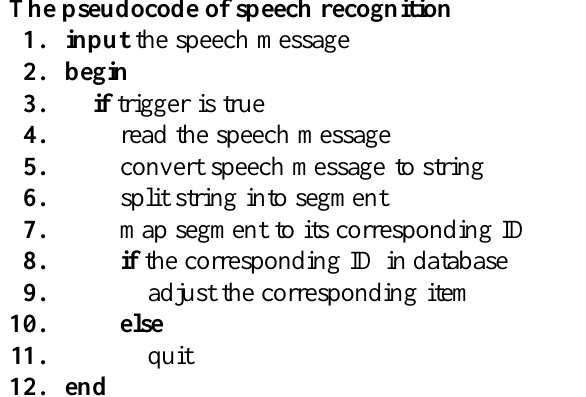
Figure 5. APP function block for the proposed smart digital mixer system.